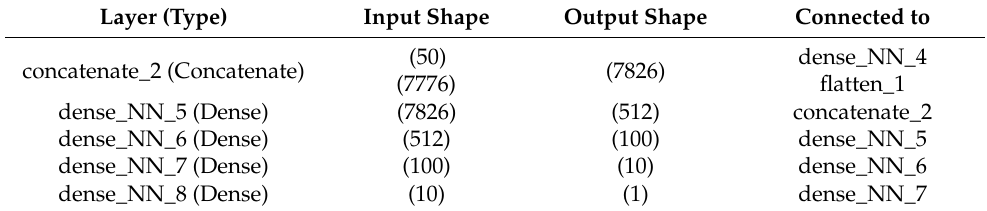
Table 5. Summary of the concatenation of output of MLP with DAEE and CNN for fully connected NN to the output